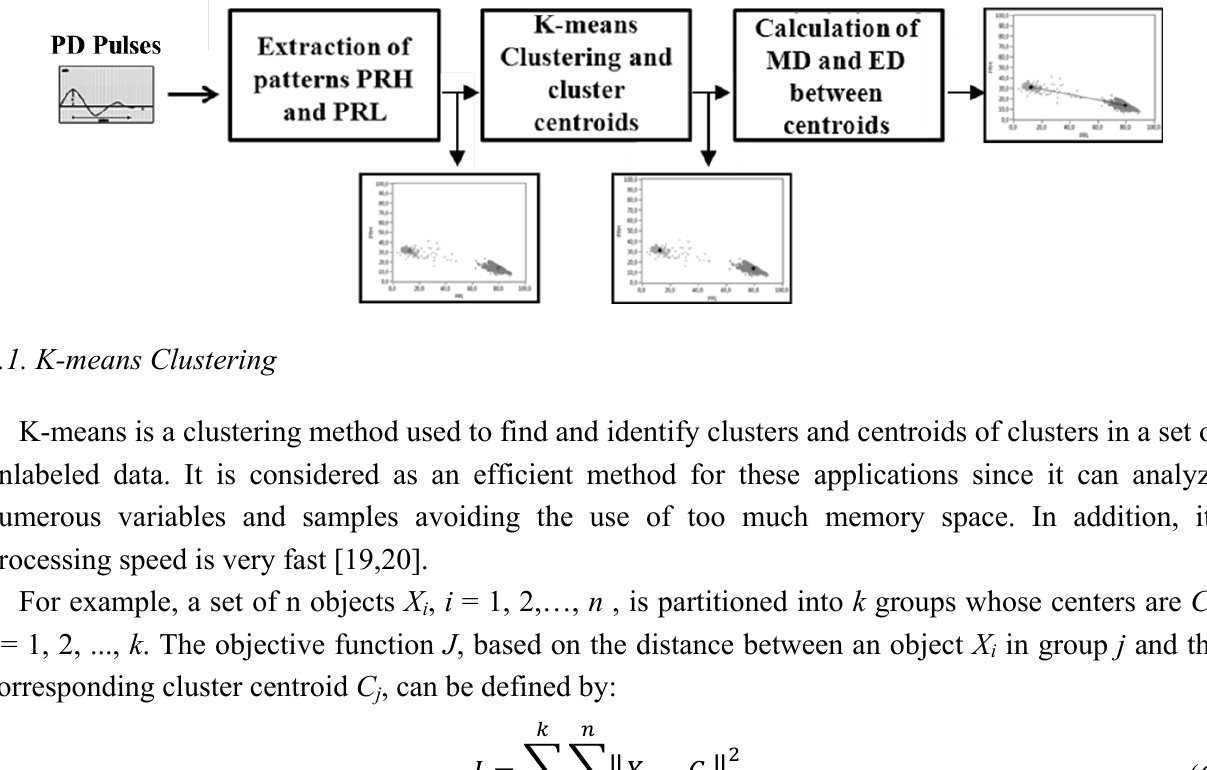
Figure 9. Schematic diagram of the